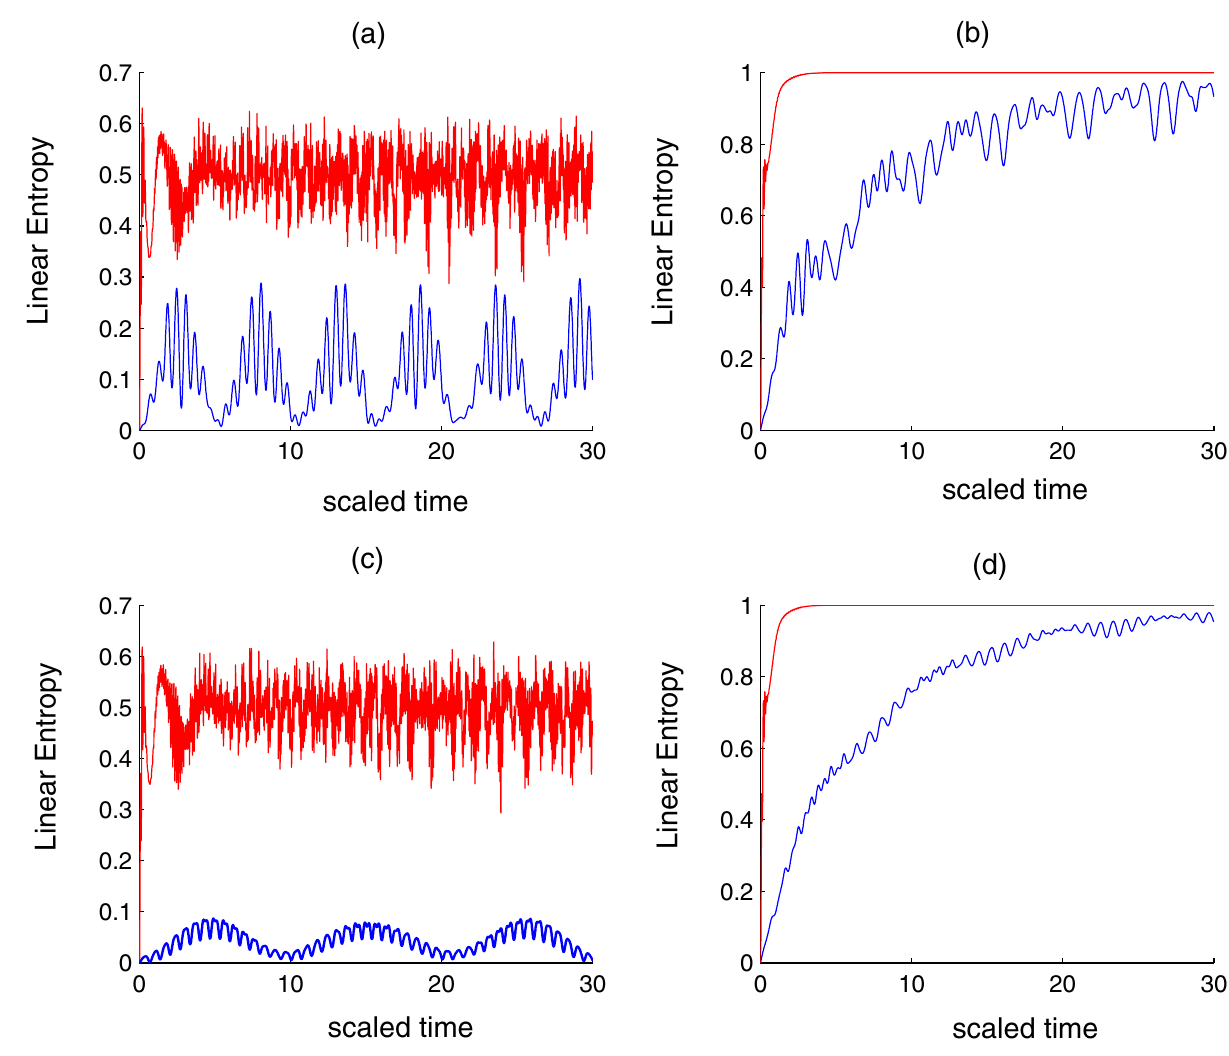
Figure 2. Time evolution of the linear entropy for the same conditions and parameters of Fig.